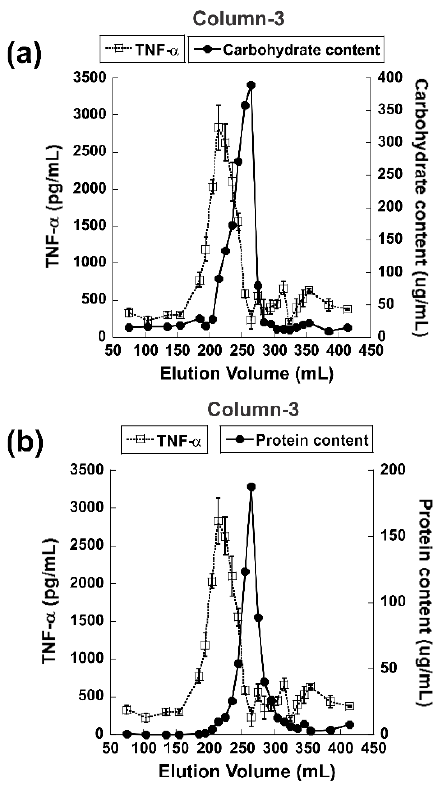
Figure 3. Purification of IMPP-Rb from R. badius using Sephacryl S-500 (column 3). Collected fractions were assessed for their ability to induce TNF- α production in RAW264.7 cells. TNF- α levels plotted against ( a ) carbohydrate contents, and ( b ) protein contents. Results are representative of three separate experiments.